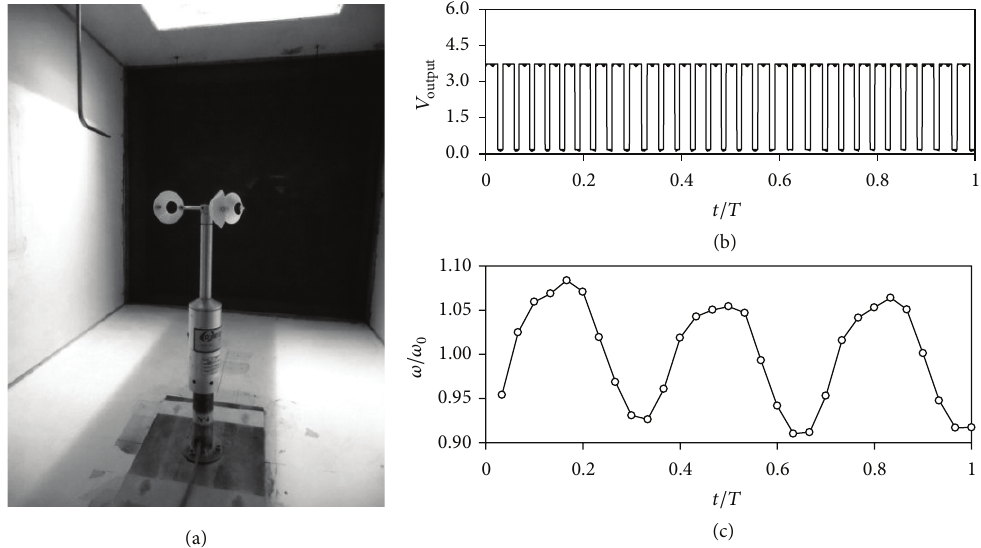
Figure 3: Climatronics 100075 anemometer placed in the S4 wind tunnel of the IDR/UPM Institute to carry out a calibration with the h-19/60 , in one turn (b). Relative-to-the-average rotational speed, 𝜔/𝜔 0 , in one turn (c). 𝑇 is the rotor (a). Anemometer voltage output signal, 𝑉 output period of the anemometer’s rotation.